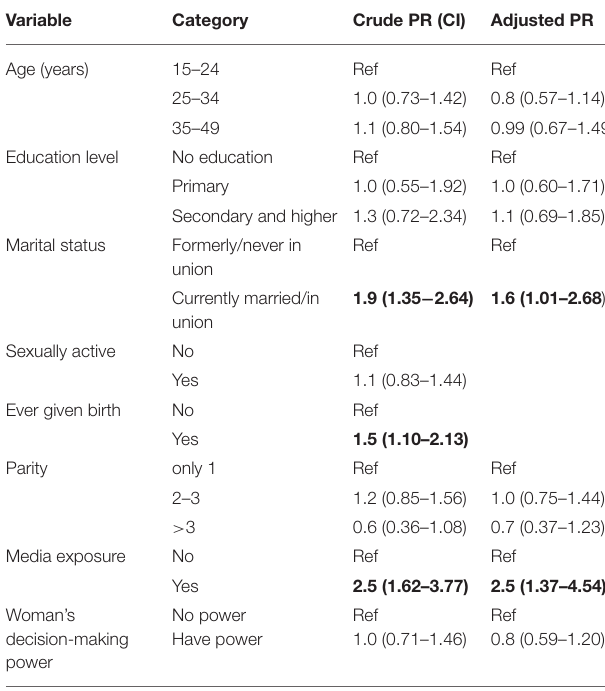
PR, prevalence ratio; CI, confidence interval. Bold values are the significant